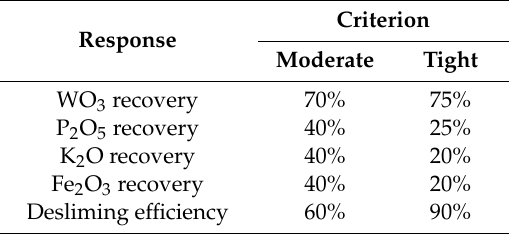
Table 3. Moderate and tight objectives based on the five studied responses for the Falcon separation